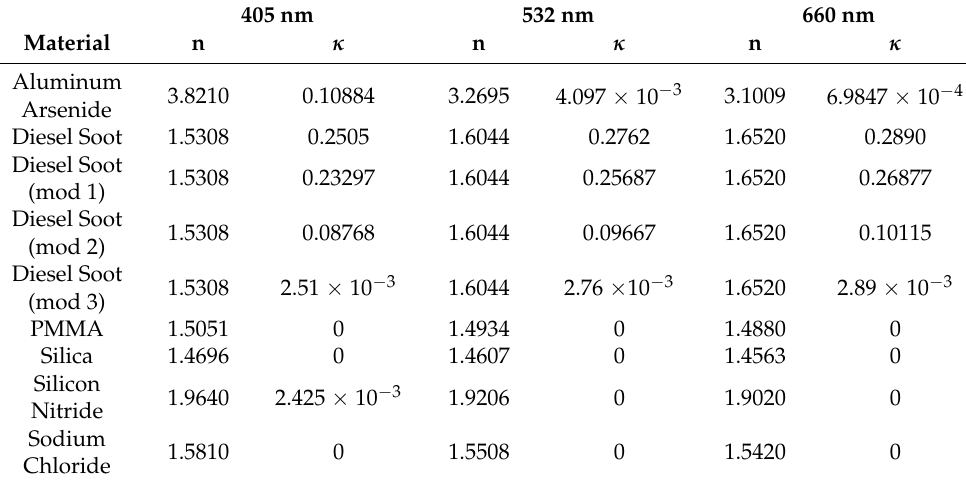
Table 1. List of the materials and corresponding complex refractive indices used as inputs with the position files for the MSTM code.